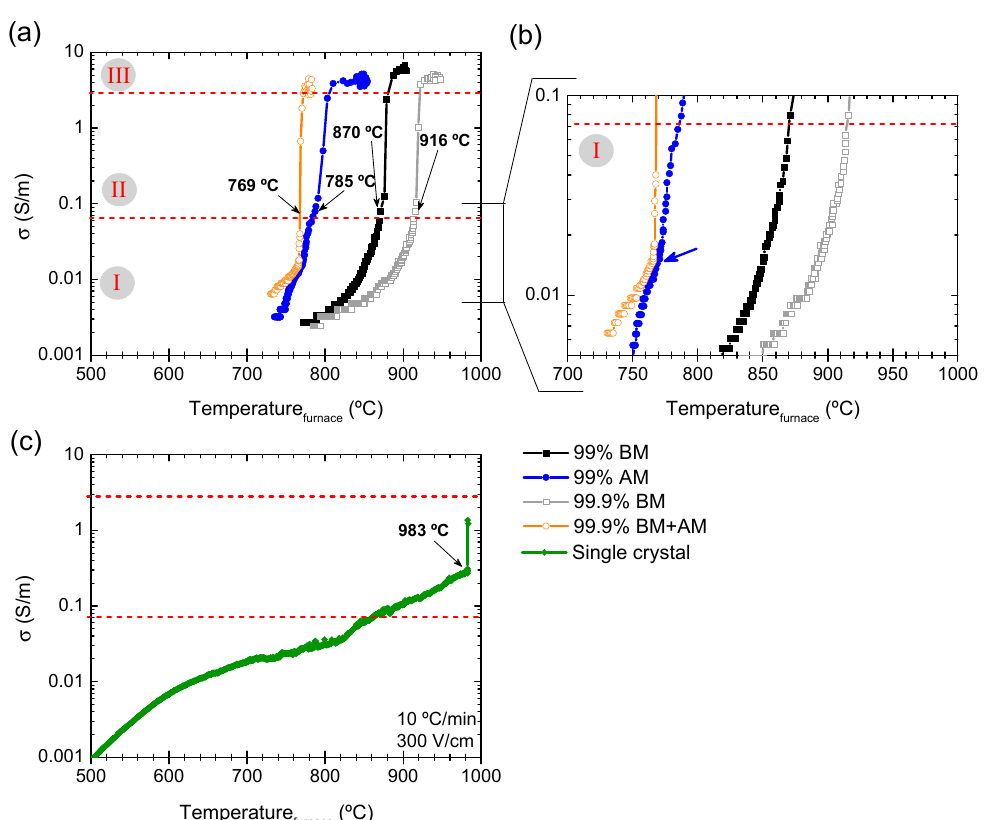
Figure 6. DC conductivity dependence (300 V/cm) versus furnace temperature for the ( a ) four different K 0.5 Na 0.5 NbO 3 powders and ( c ) single crystal (SC). ( b ) shows a detail on the representation of ( a ). The effect of particle size/impurities is observed; additionally, the FLASH sintering of the SC is revealed.